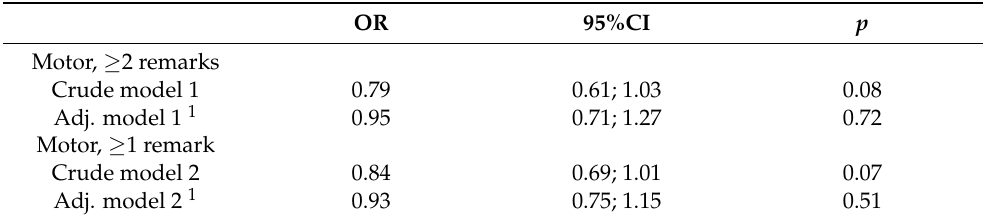
Table 2. Motor skills during the first school year among children from outdoor versus conventional kindergartens.